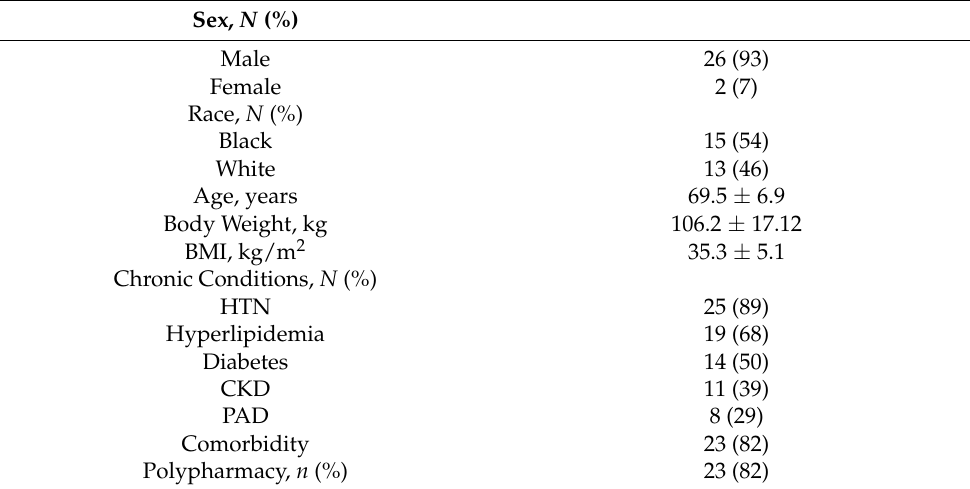
Table 1. Demographics of older Veterans ( n = 28) with dysmobility enrolled in an exercise and nutrition randomized controlled trial 1